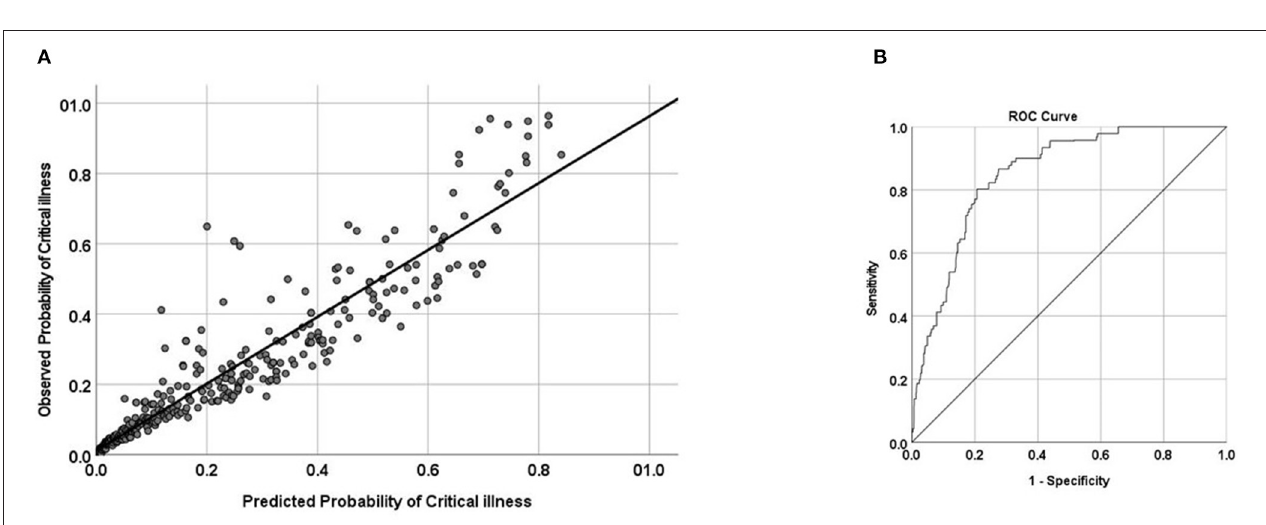
FIGURE 3 | (A) Calibration and (B) area under the receiver operating characteristic curve (AUC) of predicting critical illness in patients with COVID-19 infection. AUC = 0.851 (95% CI,